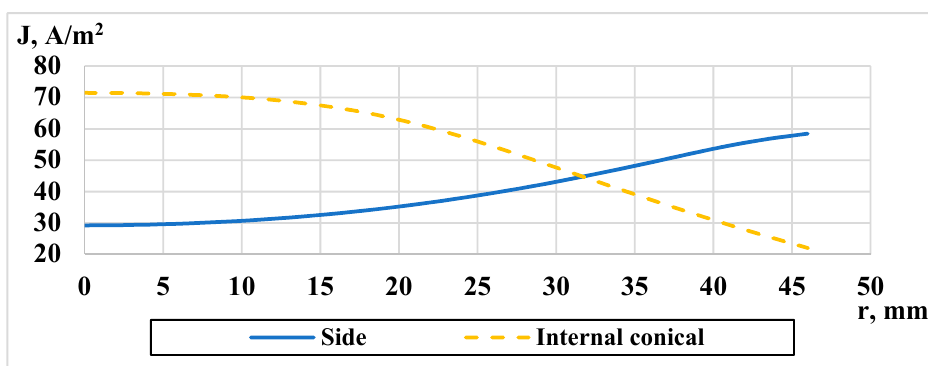
Figure 11. Radial distribution of the extracted ion current density at the xenon flow rate of 0.5 mg/s.